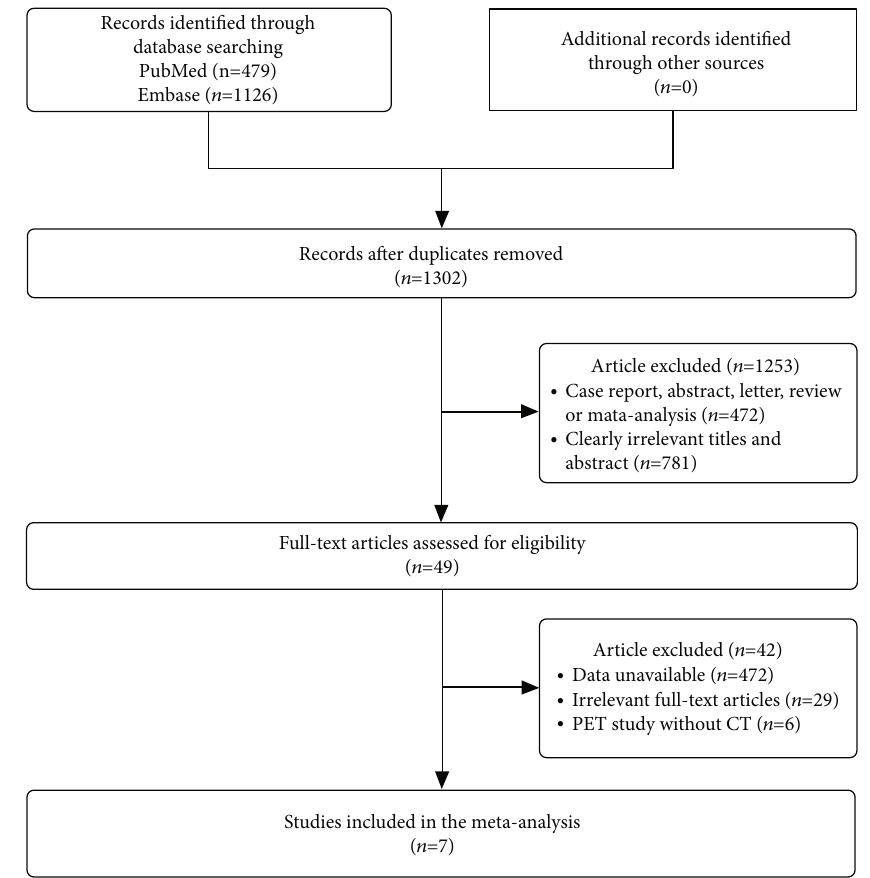
Figure 1: The study selection fl ow